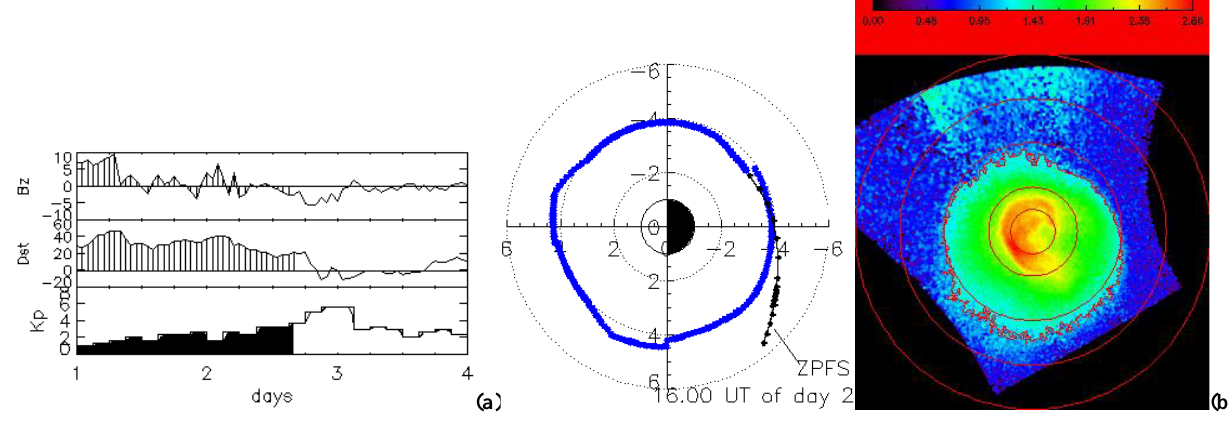
Fig. 2. Same as Fig. 1 for 9 June 2001, 16:00 UT ( (a) , simulation) and 16:04 UT ( (b) , EUV observation). The black line on the left panel corresponds to the Zero Parallel Force Fig. 3: Same as Fig. 1 for 9 June 2001, 23h00 (left panel (a), simulation) and 23h04 UT (right panel (b), EUV observation).